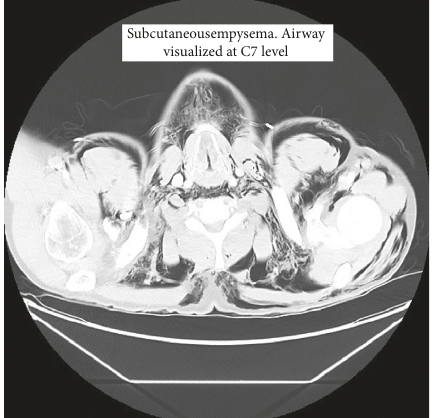
Figure 3: Axial CT image at the level of the thyroid cartilage demonstrating air infiltration around the larynx. There is notable swelling of the soft tissue of the larynx.